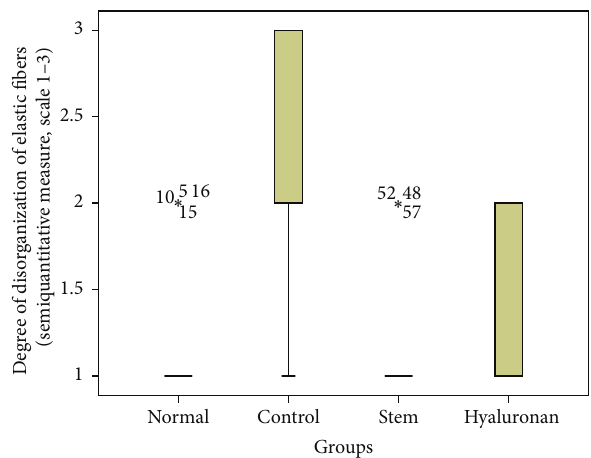
Figure 21: Density of hyaluronic acid in the superficial lamina propria (SLP). Normal = normal/control group, control = scarred/ control group, stem = stem cell group, and hyaluronan = hyaluronan group.